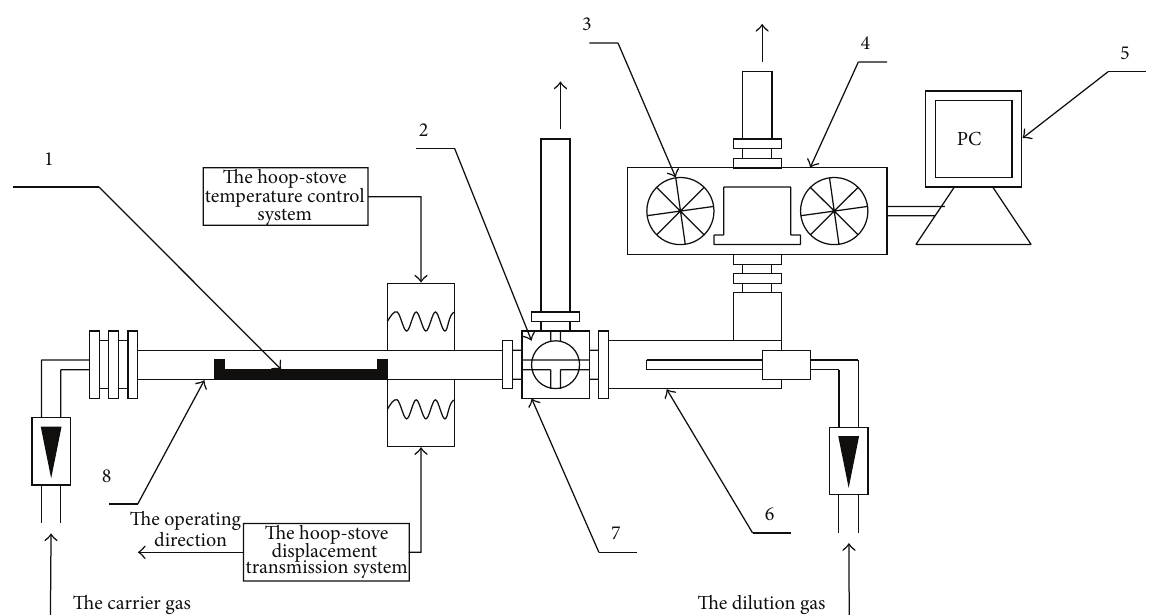
Figure 1: The schematic diagram of the smoke toxicity test device: 1. the quartz boat, 2. the three-way cock, 3. the infected box, 4. the mouse cage, 5. computer, 6. the gas distribution pipe bending, 7. the hoop-stove, and 8. the quartz tube.